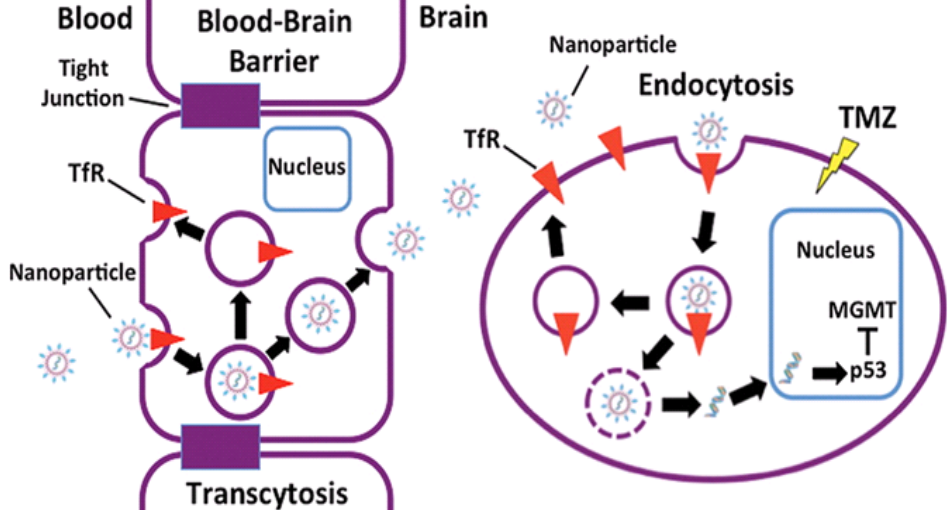
Figure 6. Schematic of BBB crossing ability of drug ‐ loaded cationic liposomes and cancer cell internalization induced by surface functionalization with antitransferrin receptor (TfR) antibody fragment designed to target TfR. Reproduced from Ref. [167] with permission of the copyright holder.